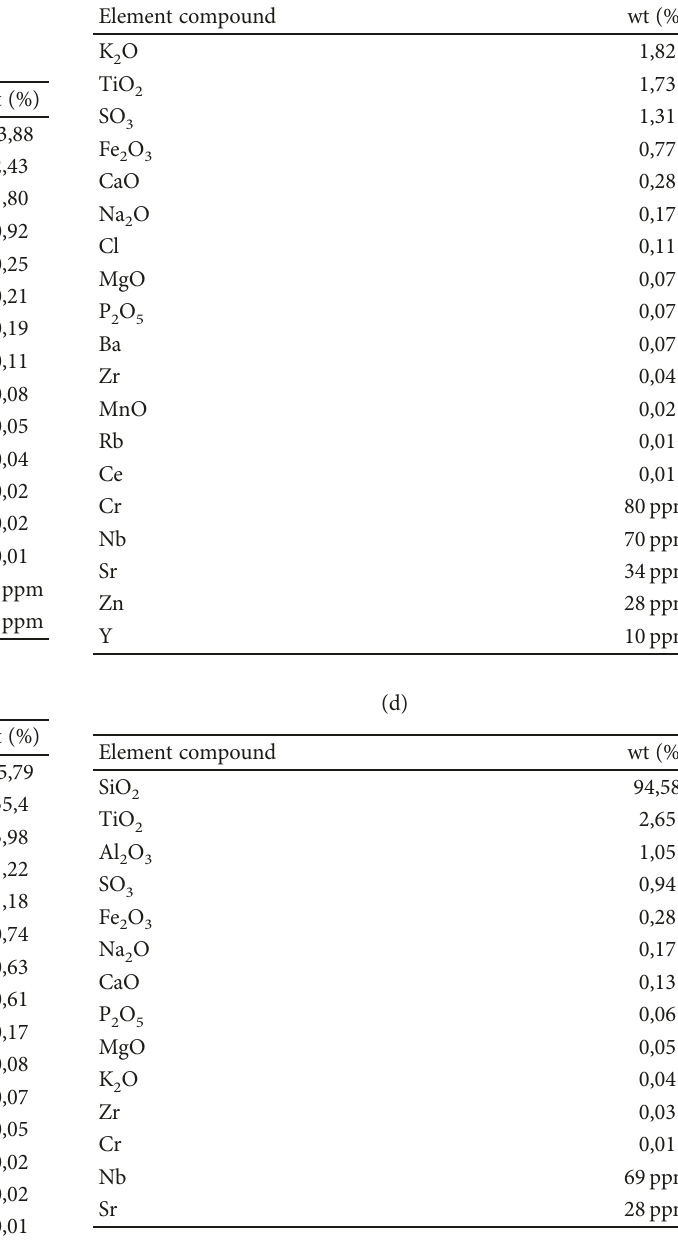
Table 7: XRF analysis of San Juan samples: (a) SJ1-A. (b) SJ1-B. (c) SJ1-C. and (d)